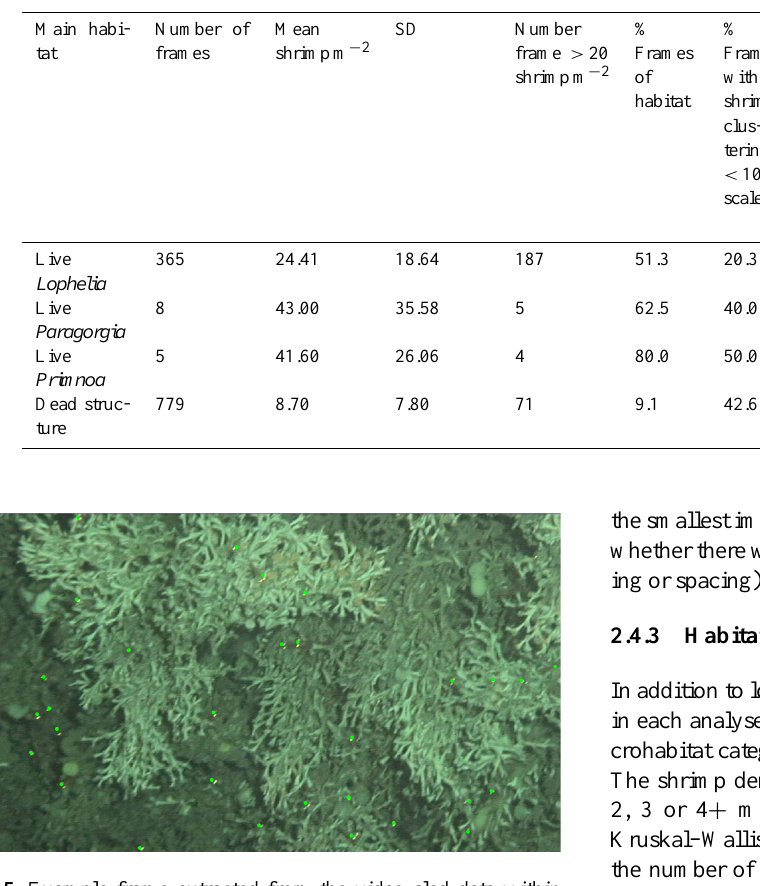
Fig. 5. Example frame extracted from the video sled data within the BIIGLE system. A number of slightly blurred shrimp eyes have been labelled in green. The image shows predominantly live Lophe- lia pertusa coral and a number of shrimp within and around the coral